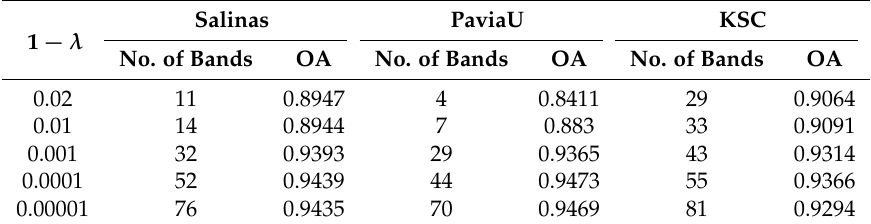
Table 6. Classification overall accuracy (OA) and the number of bands with different values of threshold λ , where the partitioning order of Partitioned Relief-F (PRF) is